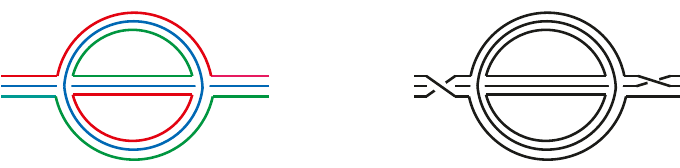
Figure 2 . Leading melonic propagator corrections in the O ( N ) 3 and O ( N ) theories. by N (cid:0) 3 = 2 compared to the melonic graphs. In the O ( N ) model the maximum scaling is g 2 n +1 N 3 n +4 , which implies a suppression by only N (cid:0) 1 = 2 compared to the melonic